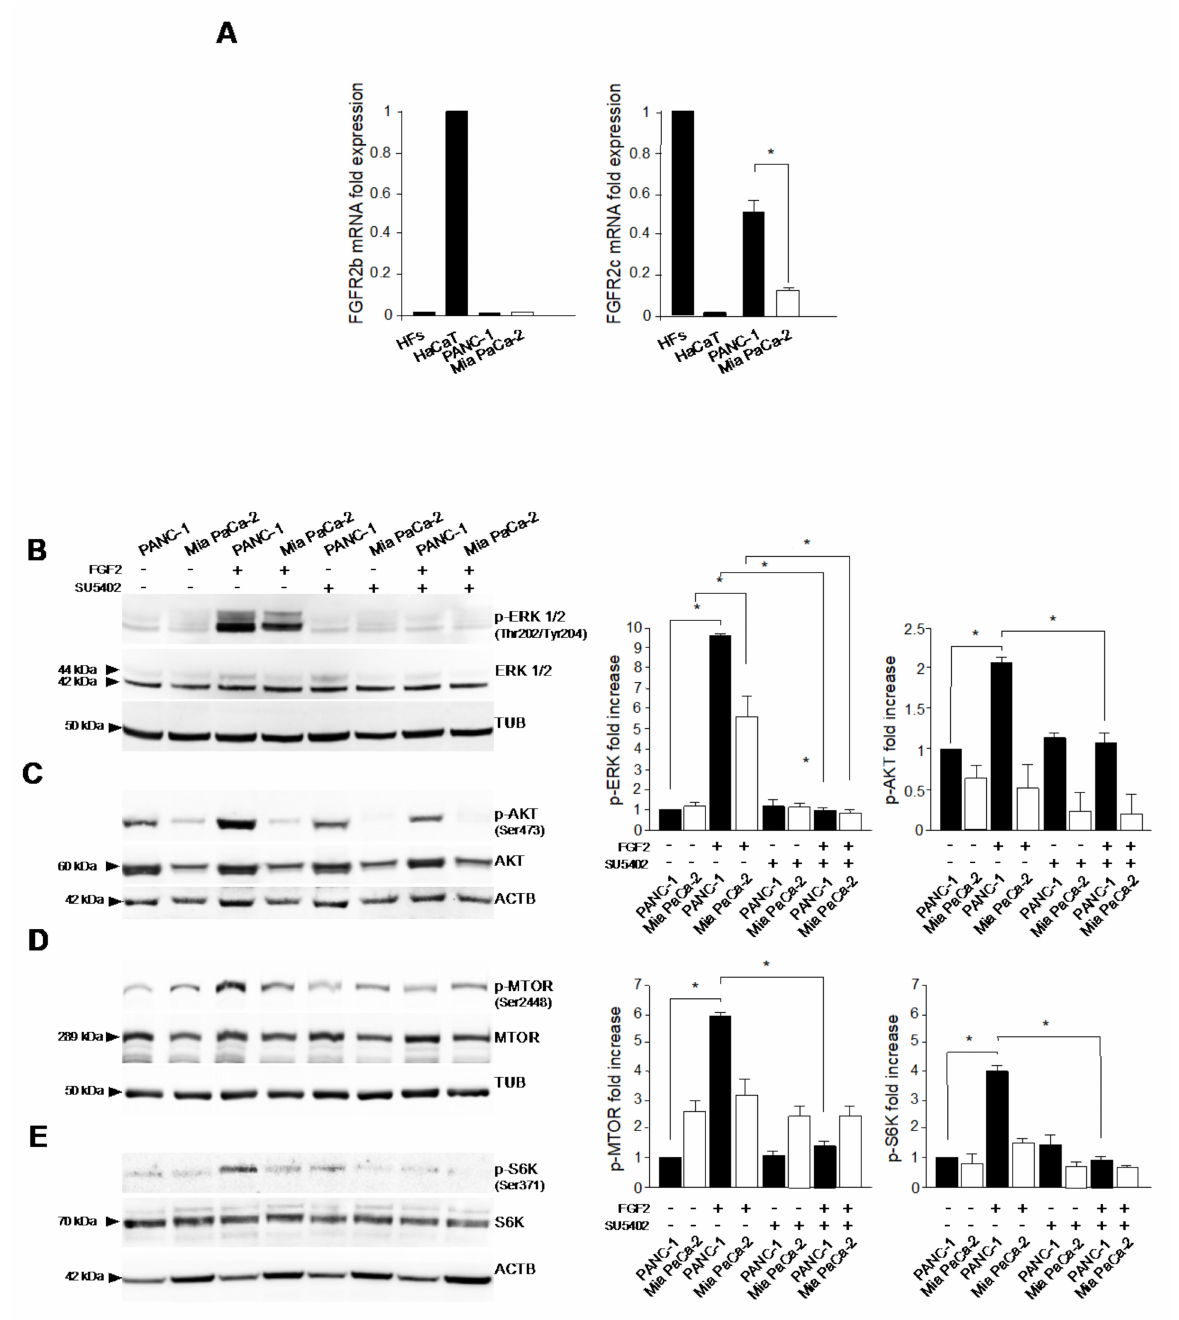
Figure 1. FGFR2c expression affects the susceptibility of ERK1/2 and AKT signaling to FGF2. PANC-1 and Mia PaCa − 2 pancreatic tumor cell lines were left untreated or stimulated with FGF2 in the presence or absence of the FGFR2 tyrosine kinase inhibitor SU5402, as described in material and methods. ( A ) Real − time RT − PCR was performed normalizing mRNA levels respect to 18SrRNA. FGFR2c mRNA levels are significantly higher in PANC − 1 cells compared to Mia PaCa − 2. No appreciable levels of FGFR2b mRNA are detected in both PDAC cell lines. Human HaCaT keratinocyte cell line and normal human fibroblasts (HFs) are used as positive controls for FGFR2b and FGFR2c expression, respectively. Results are